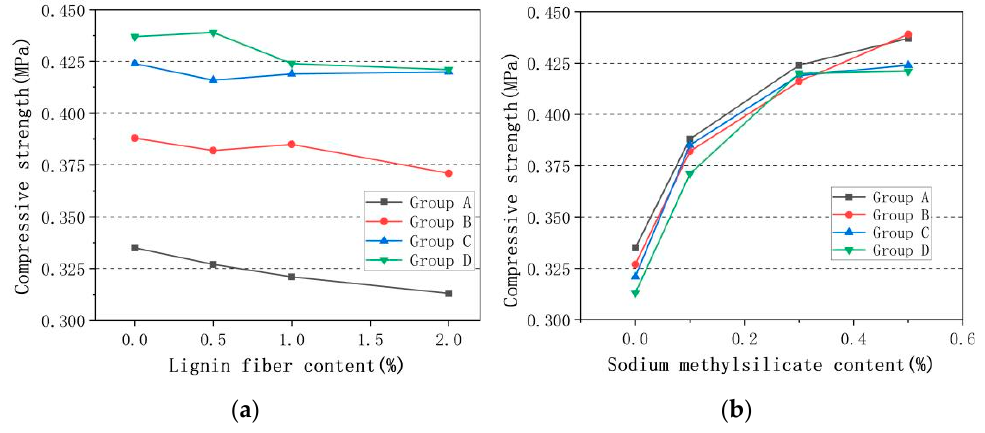
Figure 2. Relationship curve between compressive strength and material content: ( a ) change diagram of compressive strength with lignin fiber content; ( b ) Variation of compressive strength with sodium methyl silicate content.